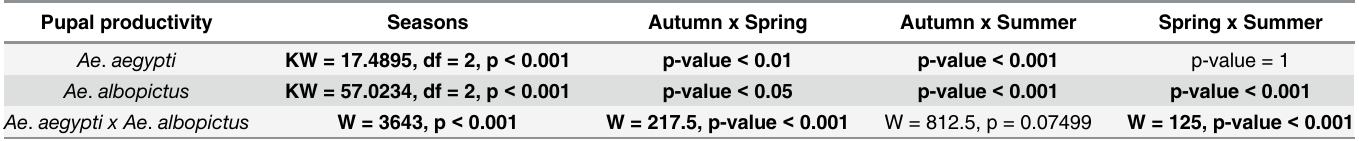
Table 4. Kruskal-Wallis test for significant differences in pupal productivity between Autumn, Spring and Summer colonization period, and Mann- Whitney pairwise comparisons with Bonferroni correction. Mann-Whitney tests were used for comparisons between Ae . aegypti and Ae . albopictus (overall and in each season).